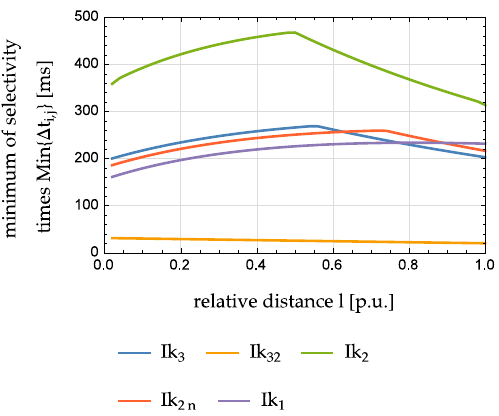
Figure 12. Dependence of the minimum selectivity times Min { ∆ tm i,j } on relative distance l for IEEE 6-bus power system where only three-phase-to-earth short-circuits are respected.